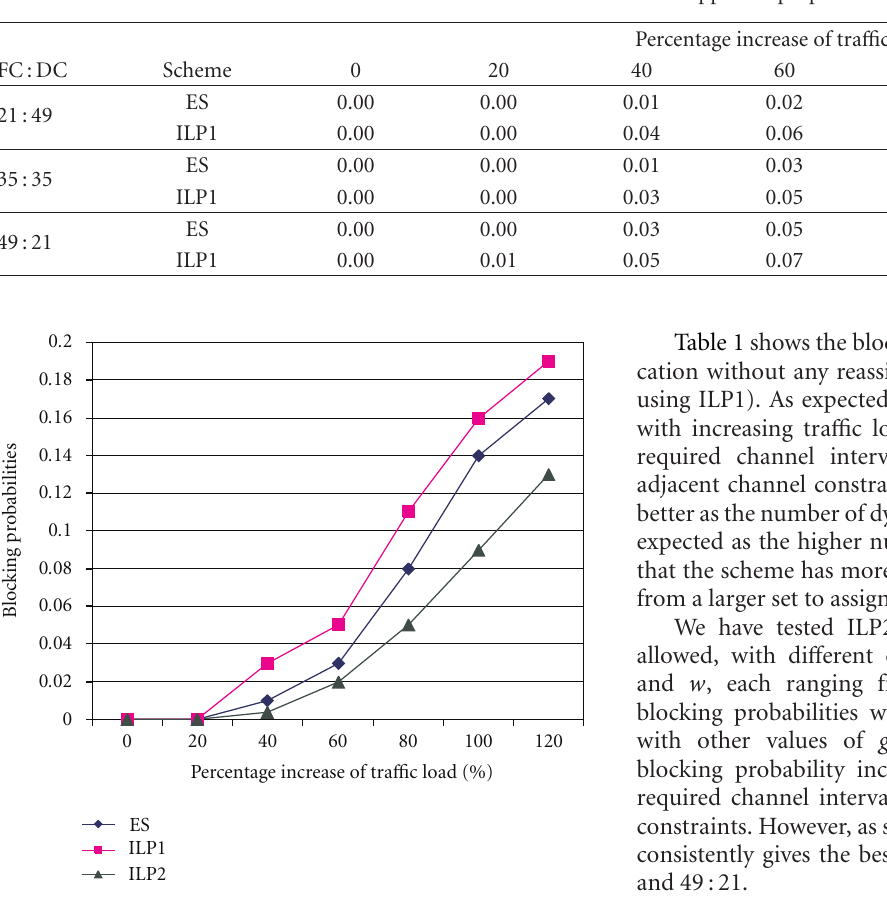
Figure 12: Relative performances of ES [6], ILP1, and ILP2 for ratio 35:35 with initial tra ffi c